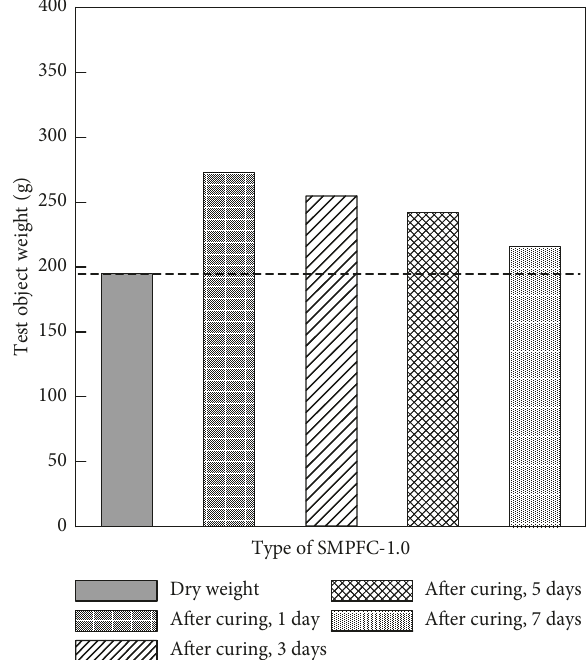
Figure 12: Test results of moisture content (SAP 0.50%).